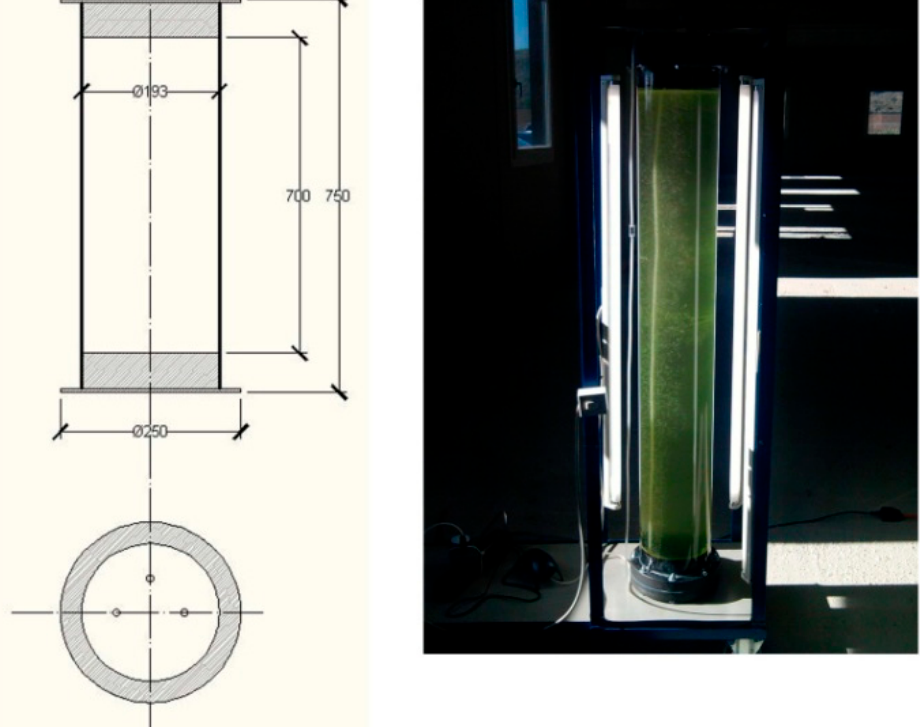
Figure 3. Plexiglass batch Photobioreactor.